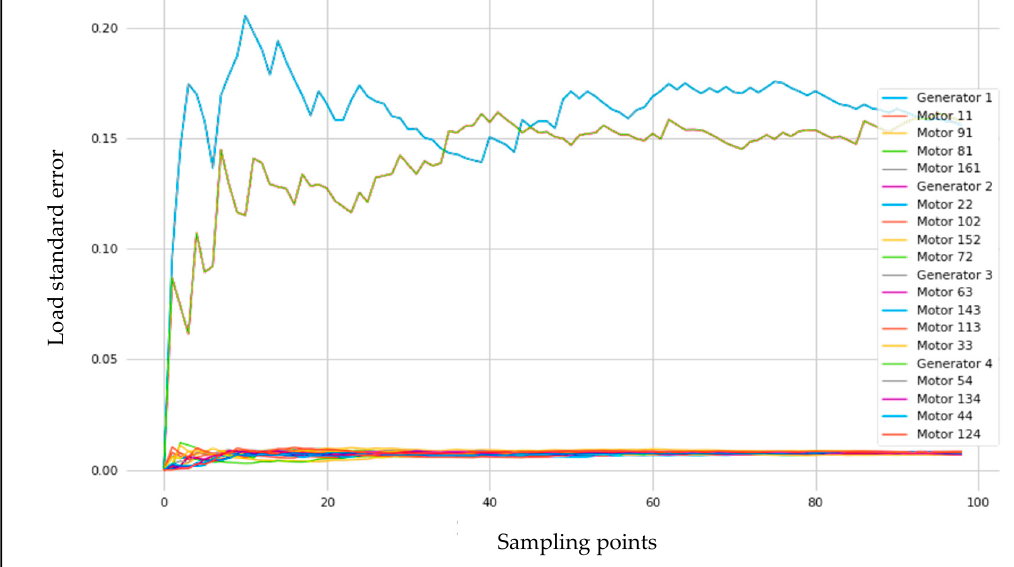
Figure 23. Latin hypercube standard deviation for the RTO case